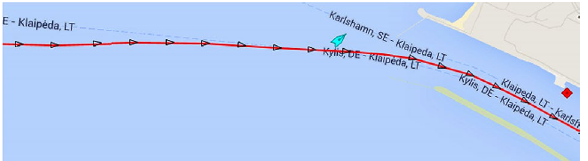
Figure 7. The entry of the SUEZMAX ship following the port trajectory was obtained employing the AIS